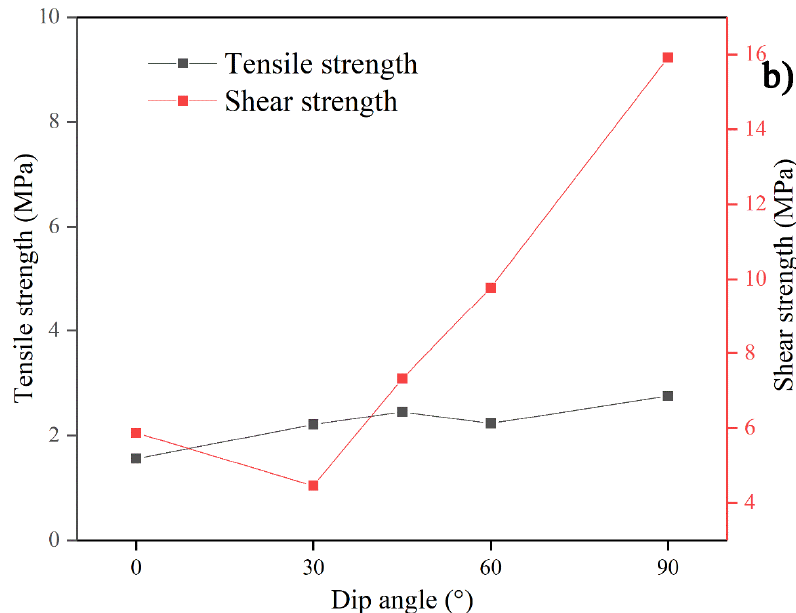
Figure 8. The graphs of red shale’s mechanical properties in different dip angles. Note: ( a ) Uniaxial Compressive Strength and Elastic modulus in different dip angles; ( b ) Tensile strength and Shear strength in different dip angles. The uniaxial compressive, tensile and shear strength are highest in vertical bedding. The strength index is the last one while the dip angle is 30°. Elastic modulus is the highest